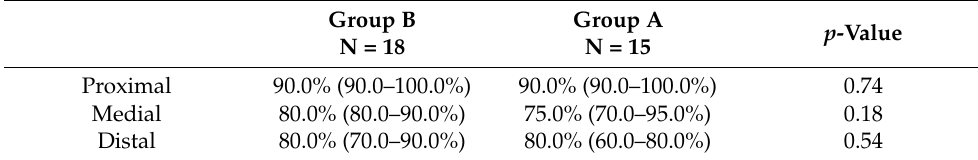
Table 6. Elastosonography measurements on operated tendon; Mann–Whitney test